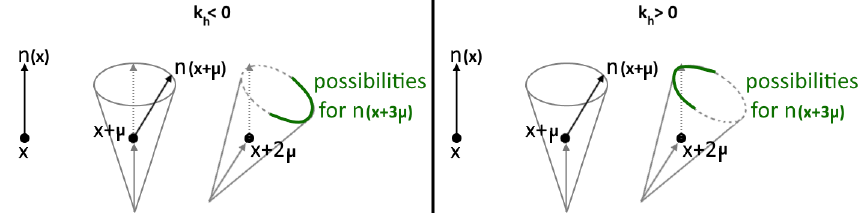
Figure 7. Starting from a lattice point x with corresponding color vector n ( x ) , the S2-homogeneity gives information about the neighbouring color vectors. The sign of k can be represented geometrically, as is depicted above. The left part can be interpreted as long range fluctuations of n-vectors, the right side as short range fluctuations of